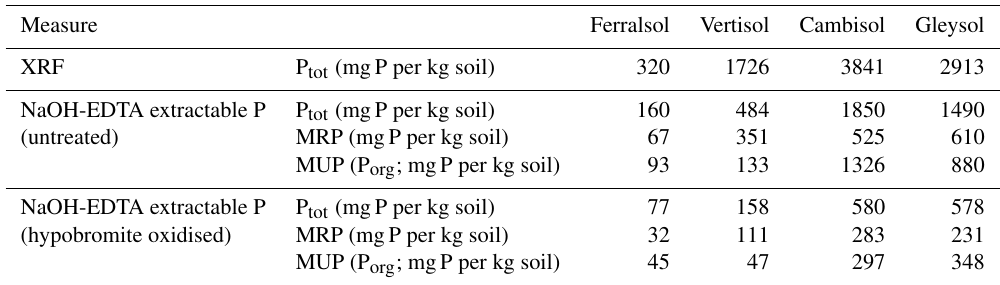
Table 3. Concentrations of total P as measured by XRF and 0.25M NaOH + 0.05M EDTA extractable P before and after hypobromite oxidation of soil extracts. Concentrations of total P in NaOH-EDTA extracts were determined by ICP-OES, whereas the concentration of molybdate reactive P (MRP) was determined by the malachite green method of Ohno and Zibilske (1991). Concentrations of molybdate unreactive P (MUP) were calculated as the difference between total P and MRP.